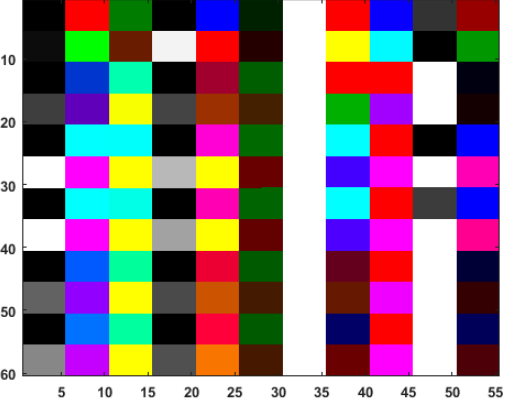
Figure 5. The feature image of a sample datapoint for six harmonic meters.